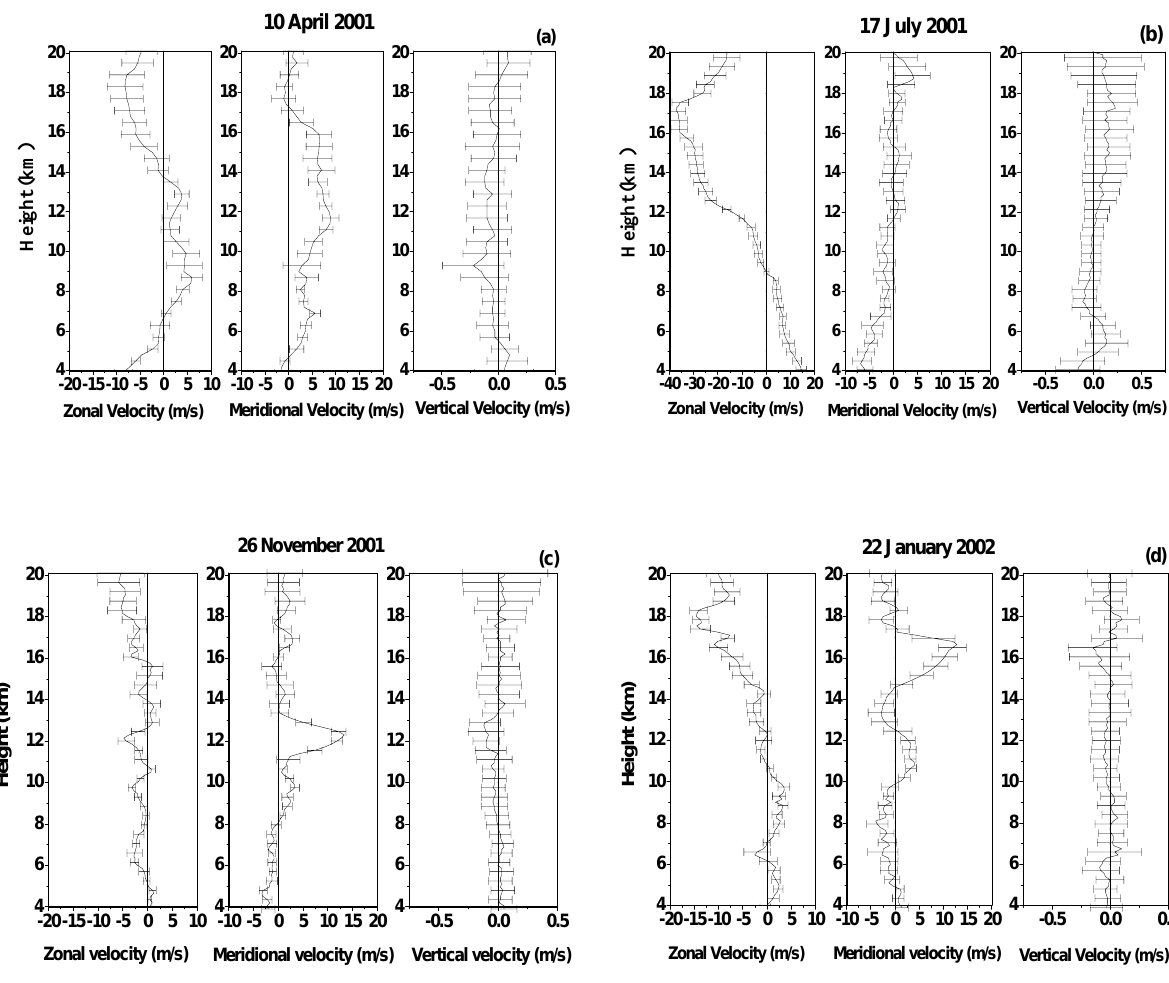
Fig. 1. Mean vertical profiles of zonal, meridional and vertical velocities along with error bars indicating standard deviations of the time period of total 6h (LT) observed during (a) 10 April 2001, (b) 17 July 2001, (c) 26 November 2001 and (d) 22 January 2002. An average is made for the entire time period of observations for 6h on each